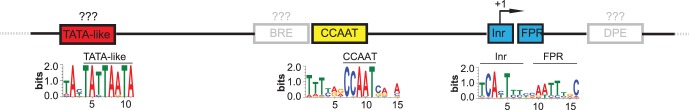
Architecture of Phytophthora promoter.Structure of the Phytophthora promoter defined by identified DNA motifs determined by our analysis or proposed to be present by indirect evidence. Identified consensus motifs are displayed below for the CCAAT-, the AT-rich TATA-like- and the Inr/FPR-element. Gene ids of the orthologs of the TFs described to bind BRE and DPE are in Table S1C.